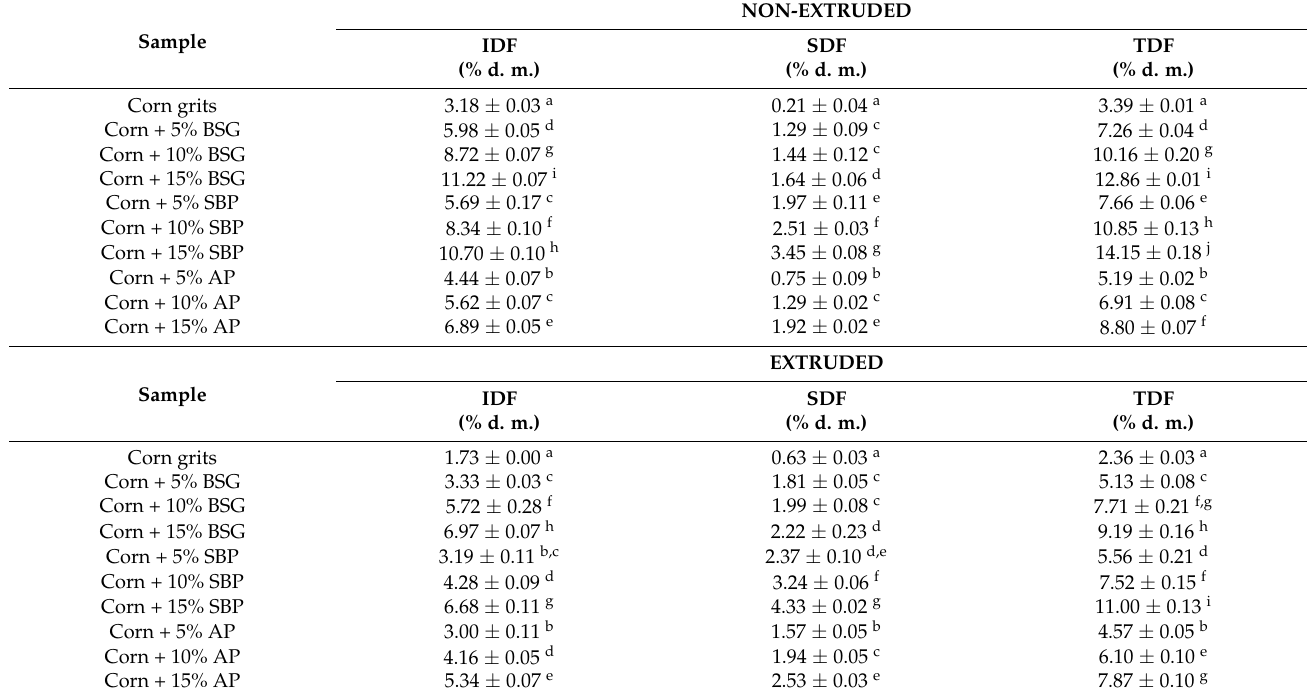
Table 2. The dietary fiber content in non-extruded and extruded